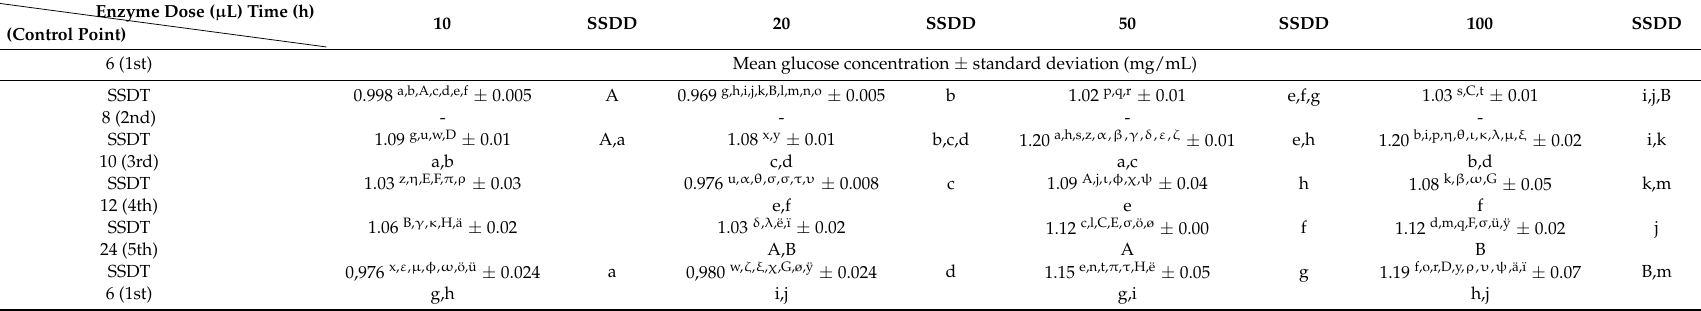
Table 3. Concentration of released reducing sugars (RRS) as glucose equivalent in enzymatic extracts from Enteromorpha prolifera at a given control point. Point)Enzyme Dose ( µ L) Time (Control